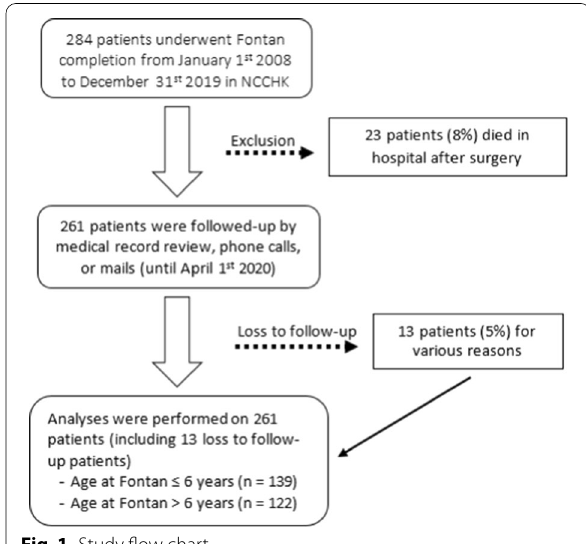
Fig. 1 Study flow chart